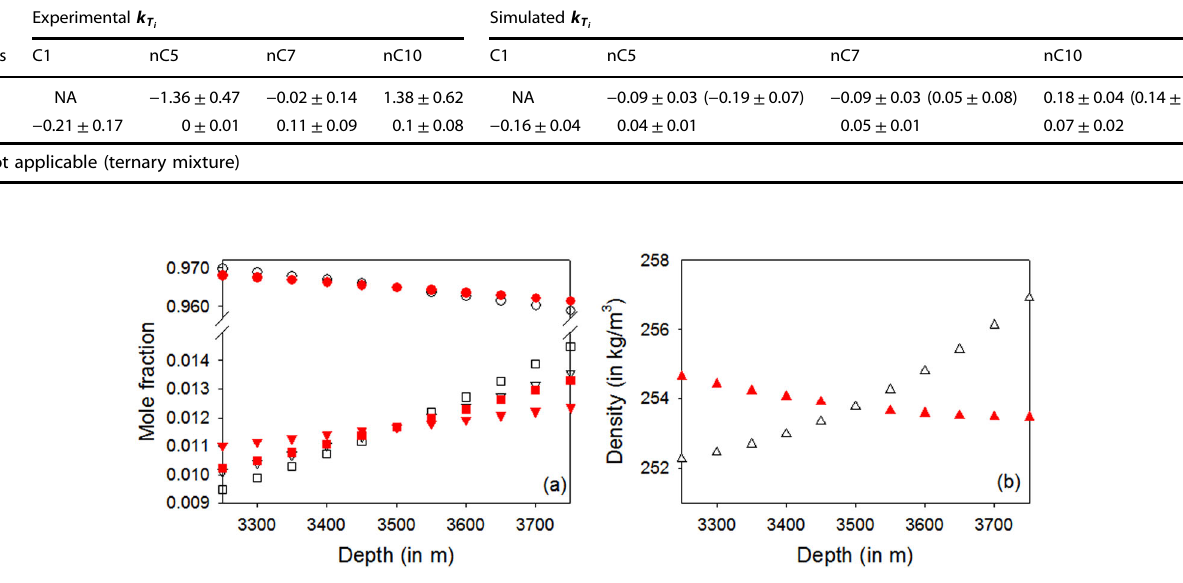
Fig. 1 Simulated species distribution a and density b of a condensate gas (cell E) as a function of depth. Open black symbol : only gravitational segregation. Solid red symbols : thermodiffusion included in the model. Left panel a : C1 ( circles ), nC7 ( triangles ) and nC10 ( squares